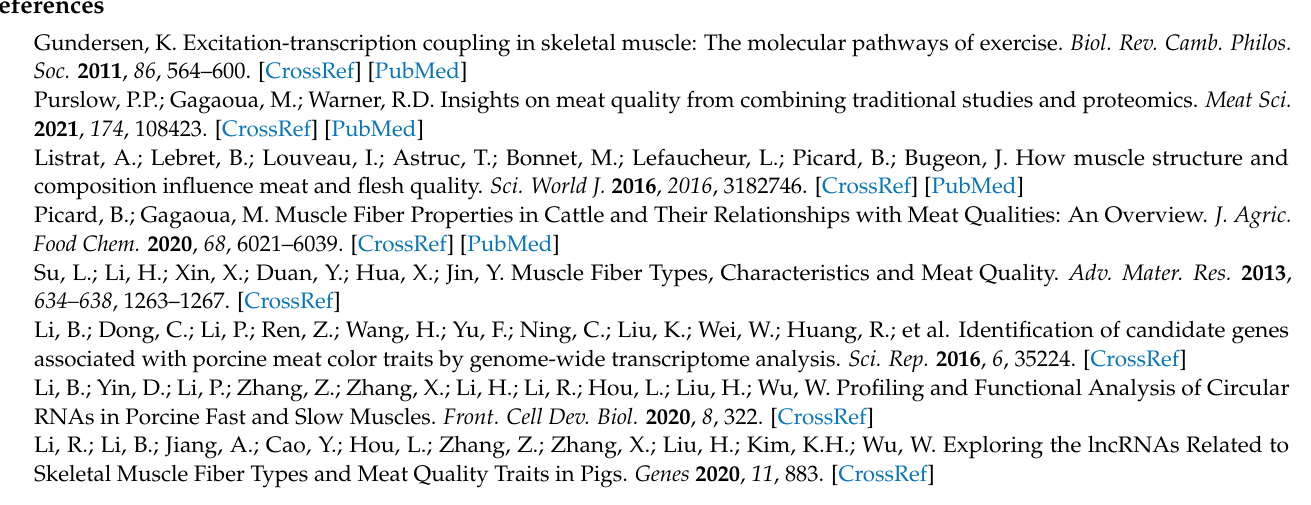
Figure S2. Summary of iTRAQ-based proteomics data for porcine skeletal muscles. Basic information statistics for spectra, peptide and protein. (B) Distribution of peptide length. (C) Distribution of protein mass. (D) Distribution of peptide sequence coverage. (E) Distribution of proteins containing different number of identified peptides; Figure S3: Heatmap of DAPs between fast-twitch and slow- twitch muscles. Protein expression were log10 transformed and displayed in colors from red (high abundance) to blue (low abundance). Columns are clustered using Pearson’s correlation distance. The samples are classified into two clusters, the first cluster comprised Bf28, Bf35 and Bf36, and the second cluster included Sol28, Sol35 and Sol36; Figure S4: Validation of DAPs and correlation analysis. (A) Validation of DAPs using qRT-PCR ( n = 3). Relative mRNA expression levels were calculated using the 2 − ∆∆ ct value method, and porcine HPRT was used as an endogenous reference gene. The x -axis represents DAPs and y -axis represents the log2 (fold change) of DAPs derived from qRT-PCR and iTRAQ data. (B) Correlation analysis of the expression of DAPs between qRT-PCR and iTRAQ data. The x and y -axis represent the log2 (fold change) of DAPs detected by qRT-PCR and iTRAQ data, respectively. Table S1: Primers used for qRT-PCR analysis; Table S2: Proteins identified in porcine skeletal muscles; Table S3: Function annotation of all identified proteins in this study; Table S4: Detailed information of DAPs between fast-twitch and slow-twitch muscles; Table S5: GO and KEGG enrichment analysis of DAPs; Table S6: Annotation information of nine quadrant associate analysis of mRNA and